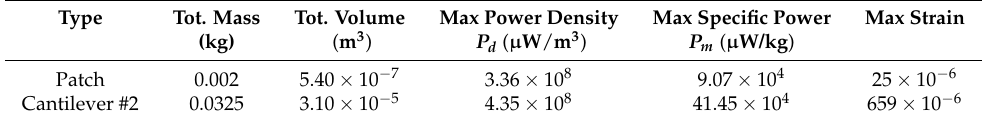
Table 5. Mass and volume of the piezo-cantilevers and piezo